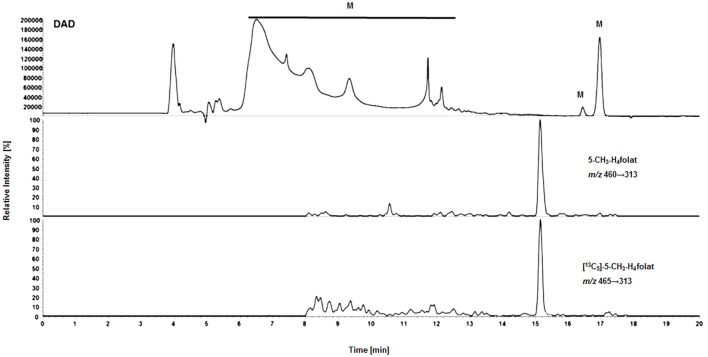
Matrix effects during LC-MS/MS measurement of extracted volumetric absorptive microsamplers. DAD (diode array detector), M (interfering compounds and inorganic salts from whole blood).